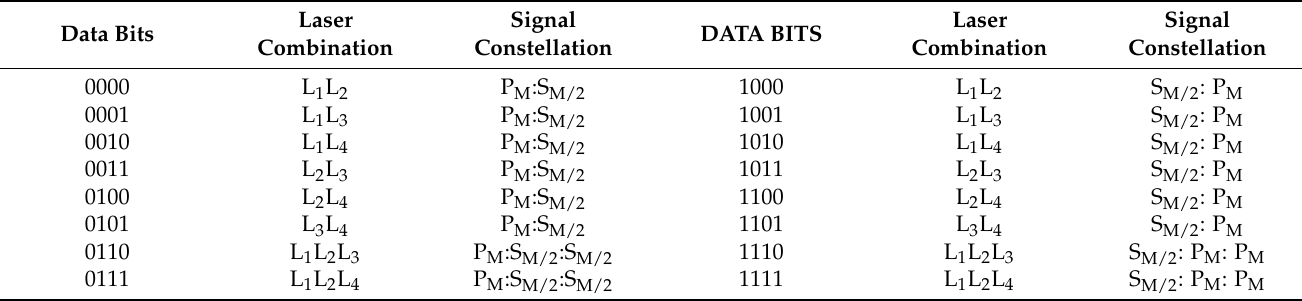
Table 1. EFOGSM system mapping